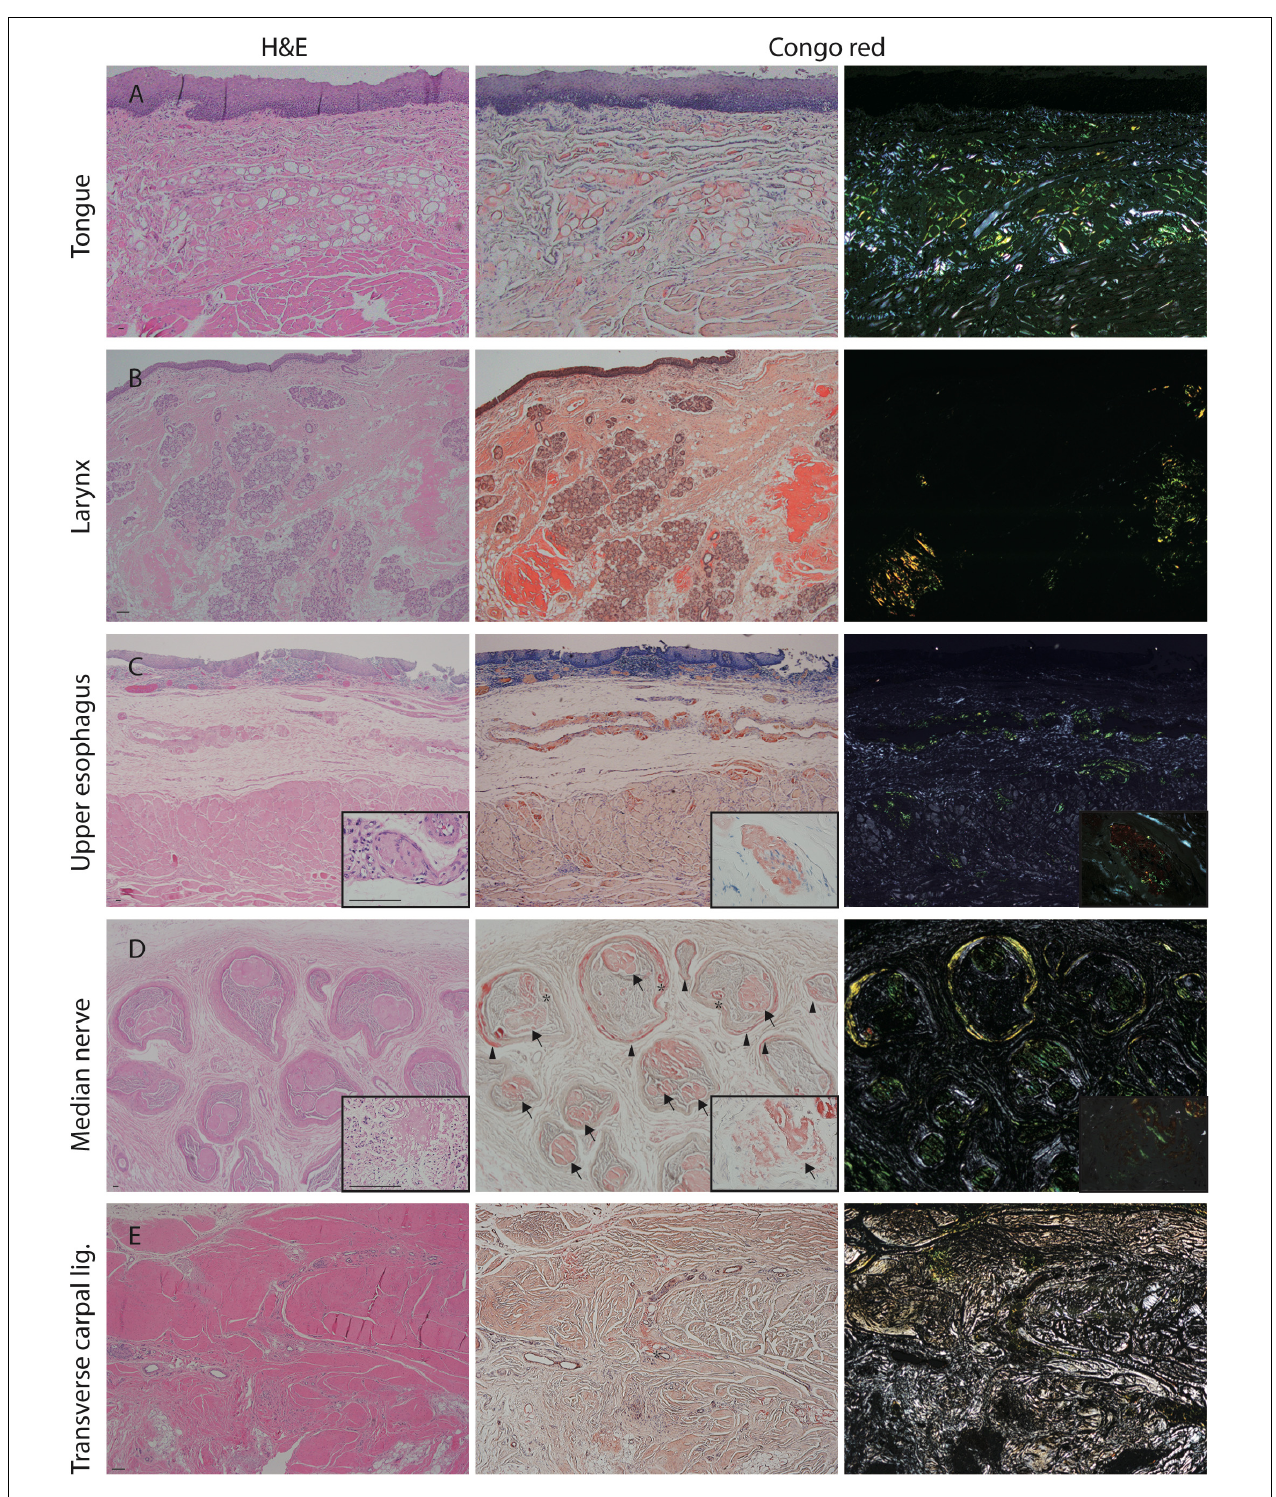
FIGURE 1 | Amyloid pathology of the median nerve and visceral organs from an autopsy of A97S patient. Amyloid deposits were demonstrated in the tongue (A) , laryngeal wall (B) , and upper esophageal wall (C) including in the submucosal nerve fibers ( C , inset). Amyloid deposits were also abundant in the endoneurium and perineurium of the median nerve at the level of carpal tunnel ( D , inset). In contrast, the amyloid deposition was much less in the transverse carpal ligament (E) . Arrow: amyloid deposits in the endoneurium; Arrowhead: amyloid deposits in the perineurium; asterisk: amyloid deposits in the vascular wall. First column: H&E staining; Second column: Congo red staining under a regular light microscope; Third column: Congo red staining under a polarized microscope. Scale bars = 50 µ m.